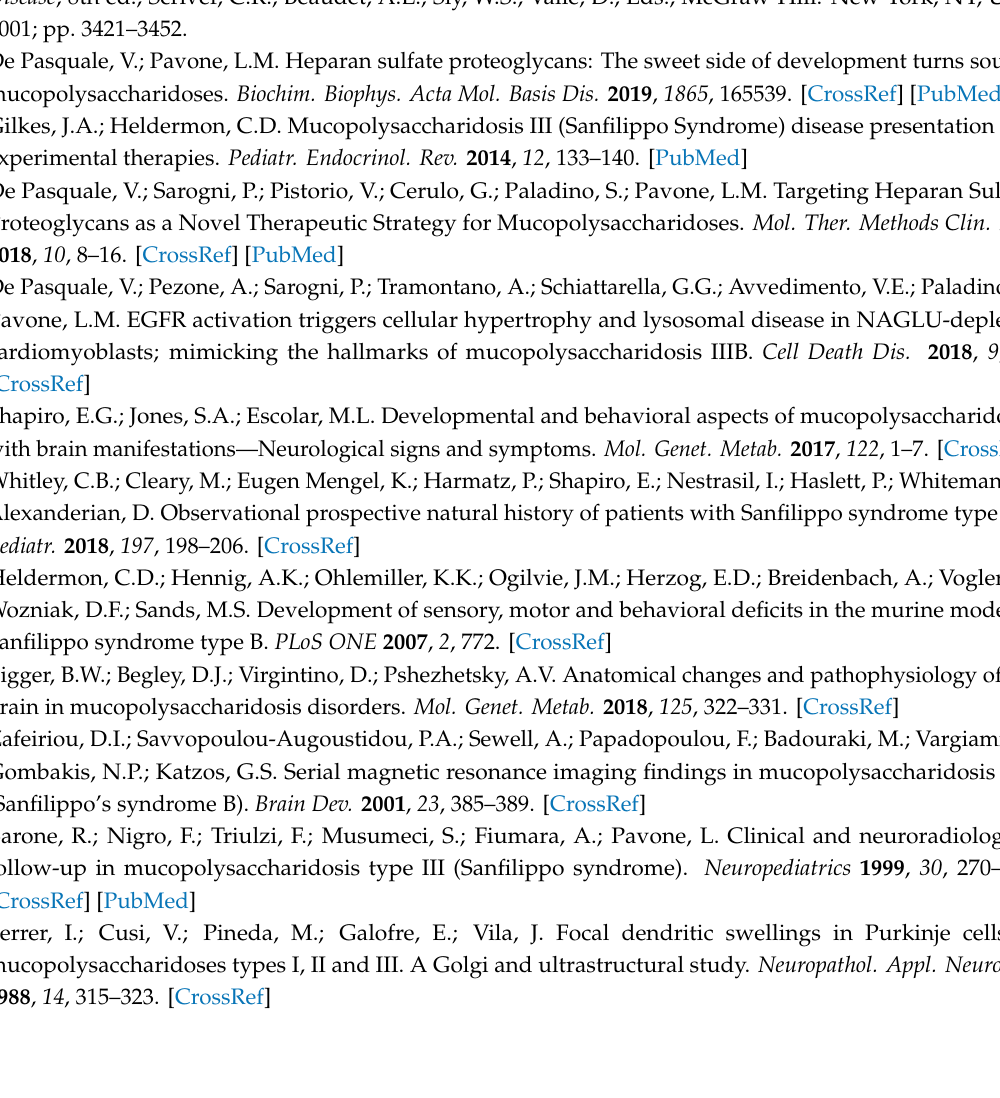
enrichment. Supplemental Figure S1: Reproducibility of the abundance parameter NSAF; Supplemental Figure S2: Normal distribution, Principal Component Analysis (PCA) and correlation matrix for WT and NAGLU − / − protein dataset. Supplemental Figure S3: Volcano plot analysis of global proteome comparison between NAGLU − / − and WT. Supplemental Figure S4: Western blotting of GFAP protein levels in NAGLU − / − and WT